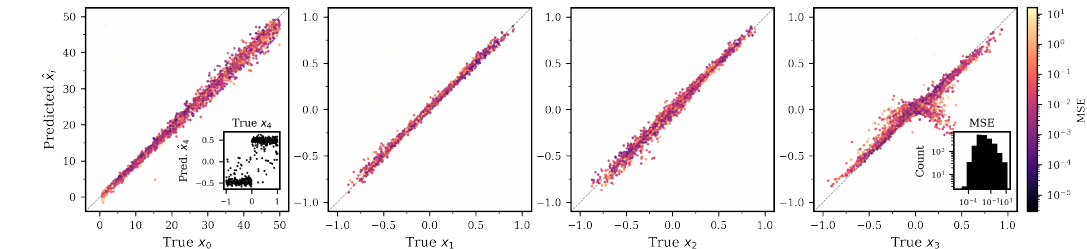
Figure 6: True Stevens coefficients x versus predicted coefficients ˆ x for hexag- i i = 4000 data sets. The onal ¯6m2 point group and J = 15 / 2 for N testing color denotes the MSE and the inset histogram in the right most panel shows the distribution of the MSE. This network was trained using nine 1D observable ( T , b ) , χ ( t ) , c ( t ) } . The MAEs of the Stevens coefficients are data sets, { µ a i a i M i { MAE ( 0 ) ,...,MAE ( 3 ) } = { 1.325 K,0.024,0.031,0.073 } . The sign of x was cor- 4 rectly predicted in 96% of the cases (see inset in left most panel). The average MSE is 〈 MSE 〉 = 0.280.